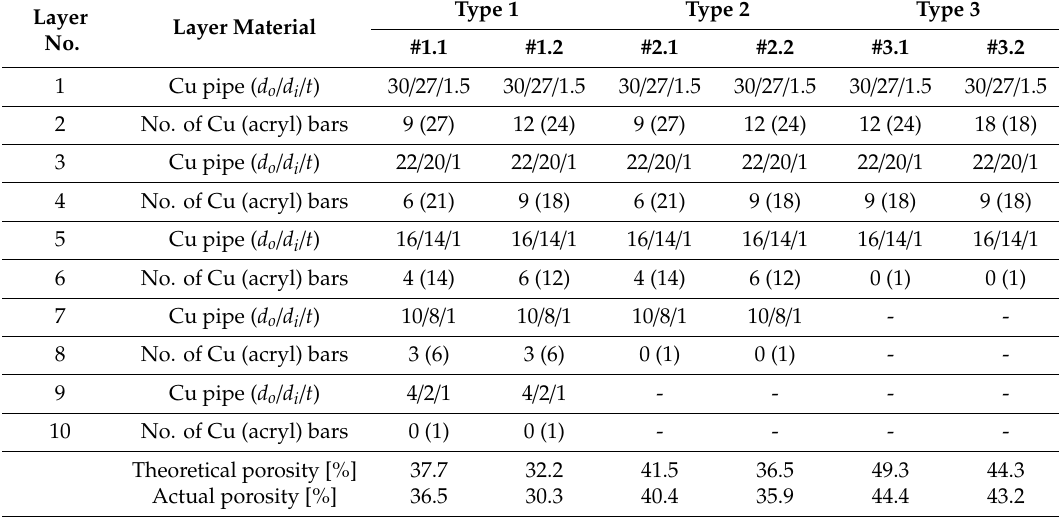
Table 1. Geometrical properties of the fabricated